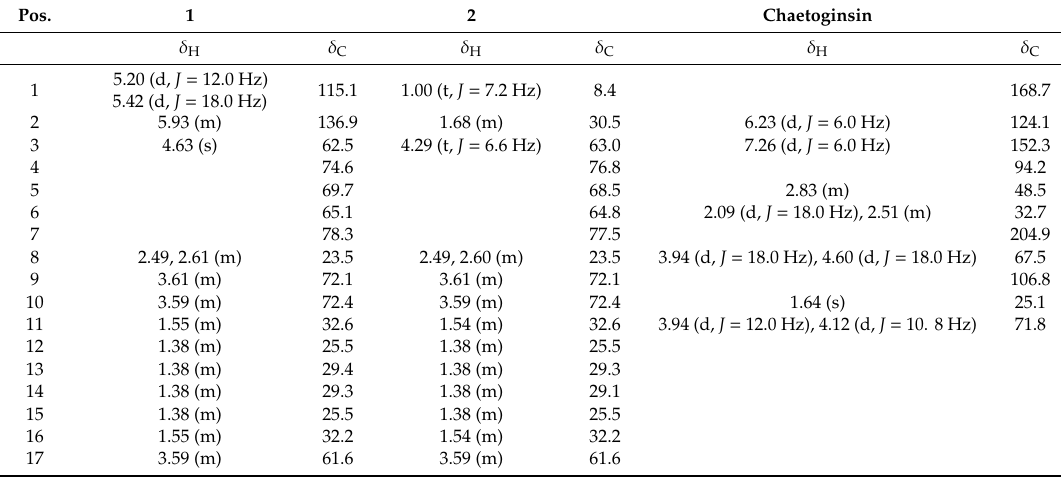
Table 1. 13 C Nuclear Magnetic Resonance (NMR) and 1 H-NMR data of compounds 1 – 3.